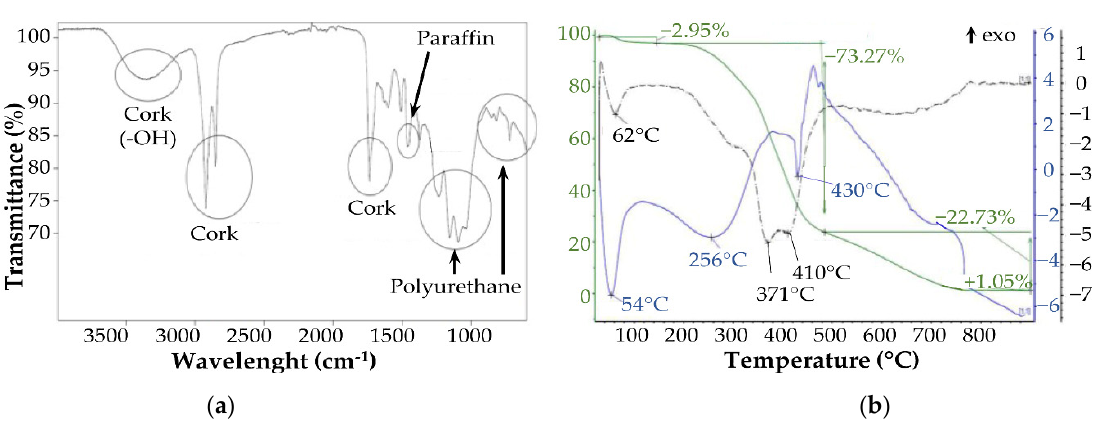
( b ) Figure 3. Optical microscopy images of cork waste: ( a ) 8× magnification, ( b ) 35× magnification. Remarkably, a water absorption of 177% was detected for cork waste, which is a con- sistent value considering the low particle size of the cork powder [27,30]. Moreover, an apparent density of 340 kg/m 3 and a real density of 1110 kg/m 3 were registered. These values are slightly higher than those about virgin cork from the literature [27] but are consistent considering the presence of polyurethane glue and paraffin. 3.2. Characterization of Mortars Containing Cork Waste A good and homogeneous distribution of cork within mortars was detected for all the design mortar mixes through optical microscopy. A comparison between the reference mortar without cork (Figure 4a) and mortar with 4 wt% (Figure 4b) is reported as a repre- sentative comparison for the other mixes in Figure 4. In Figure 4b, the cork particles, rec- ognizable by their characteristic color, are well distributed within the matrix and have both fine and coarse particles. Moreover, it can be observed that the maximum size of cork particles is smaller than that of natural aggregate (gray grains).